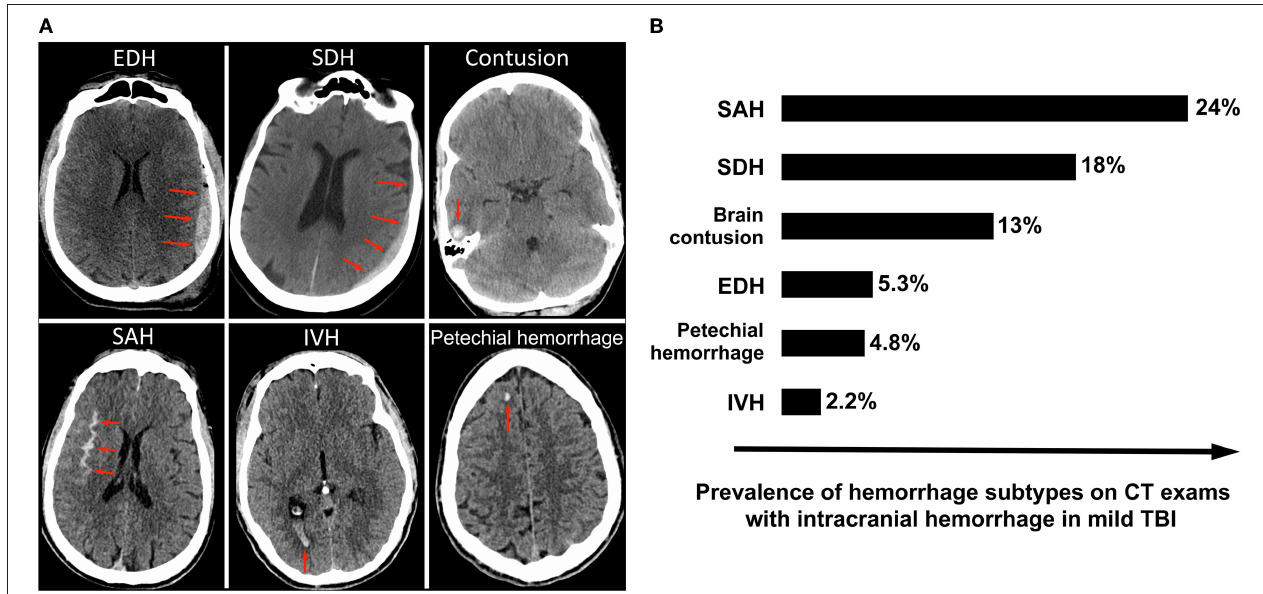
FIGURE 1 | Intracranial hemorrhage subtypes and their frequencies among mild TBI patients enrolled in the TRACK-TBI prospective longitudinal study of acute TBI ( 39). (A) Illustrates the various subtypes of intracranial hemorrhage, with red arrows indicating the abnormal lesion. (B) Shows the frequencies of each subtype of hemorrhage. SAH is the most commonly observed subtype, followed by SDH and contusion. Although the overall average incidence of “complicated” mild TBI (mild TBI with presence of acute intracranial hemorrhage on head CT) in the U.S. is lower in clinical practice than in TRACK-TBI (40), the relative distribution of hemorrhage subtypes within mild TBI is likely similar